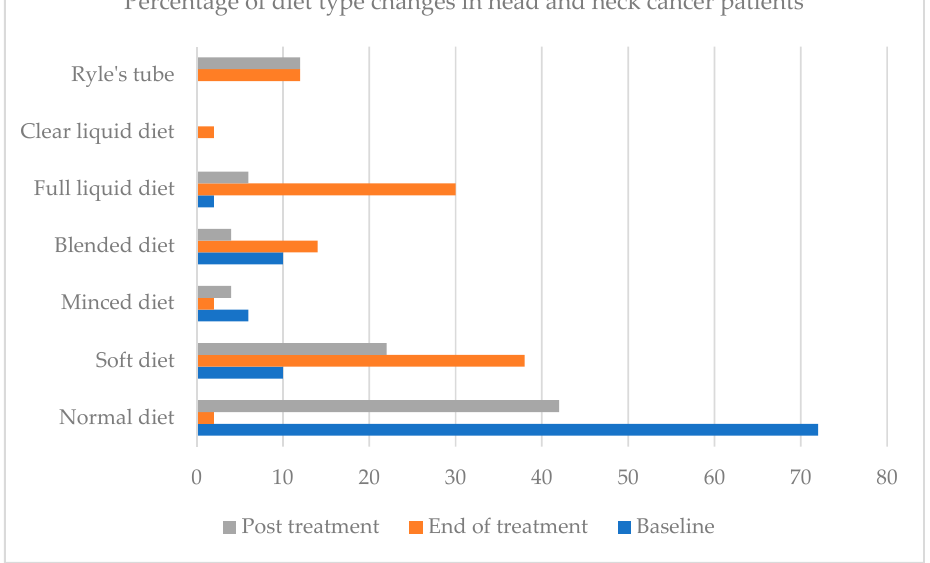
Figure 1. Changes of diet type at baseline, end and post-treatment of head and neck cancer patients. At the beginning of treatment, the majority of HNC patients (90%) did not receive any oral nutritional supplement (ONS). However, 96% of HNC patients were on ONS at end of treatment and 80% of HNC patients at post-treatment (Table 3).